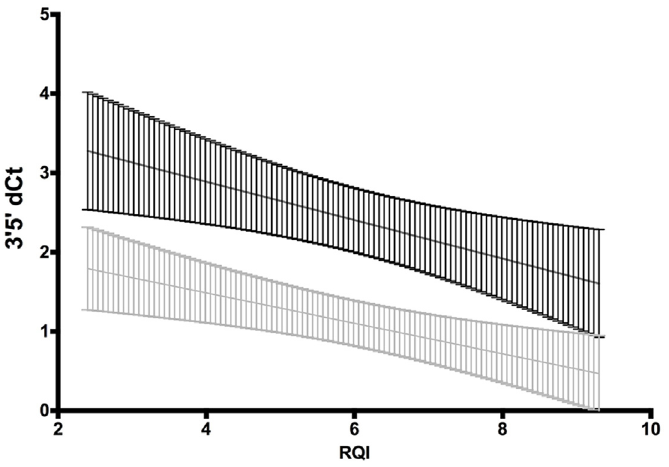
Fig 2. 3 ’ 5 ’ dCt ratio of 2 housekeeping genes versus RNA RQI values. 3 ’ 5 ’ dCt RT-qPCR ratio of TBP (black) and B2M (gray) housekeeping gene measured in adenocarcinomatous samples. The ratio is inversely correlated to the RNA integrity assessed by the